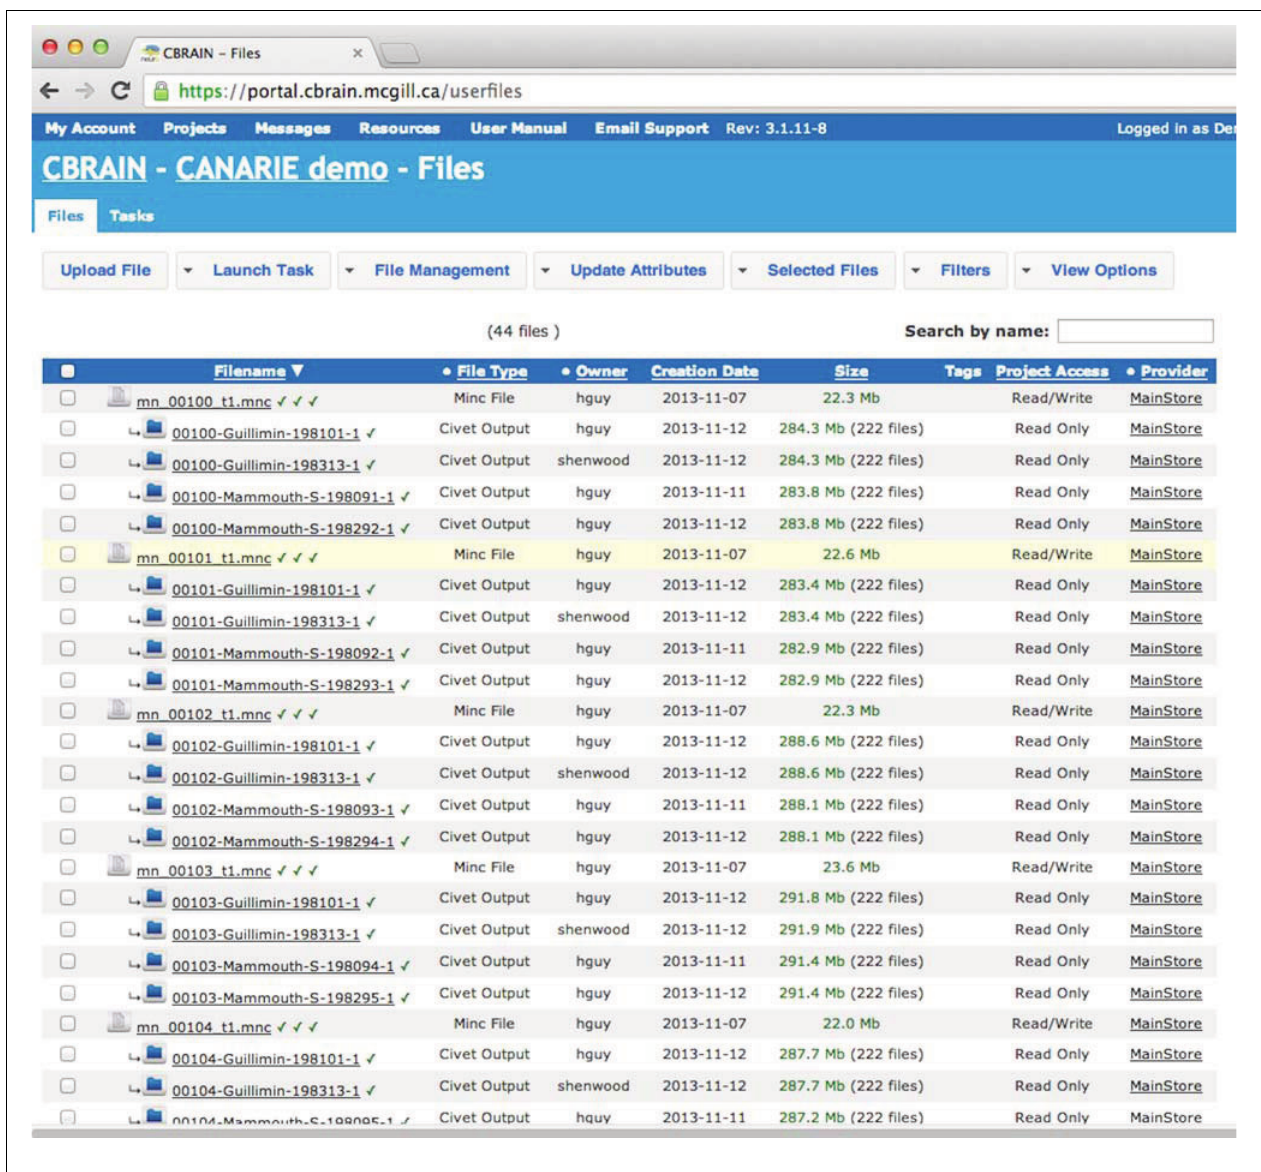
FIGURE 3 | CBRAIN portal: file view. The file view is the main control space where users can manage file or file collection properties (name, privileges, project, tags, type, physical location), filter and select input files based on any property and select a tool for a given task. Web uploads and downloads can